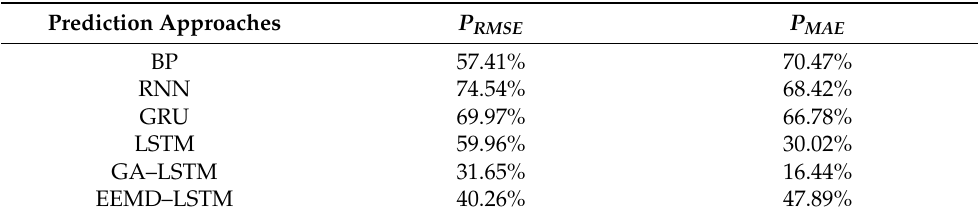
Table 4. Percentage improvements of the proposed method in comparison with the other approaches on propagation loss sequence 1 (evaporation duct).